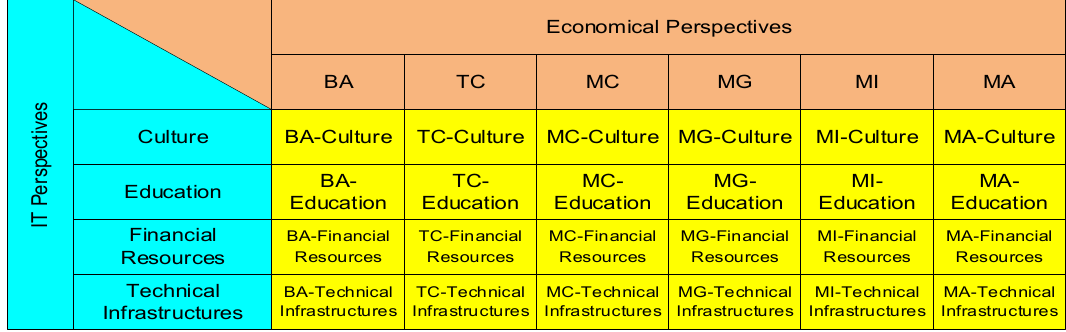
Fig. 1. A conceptual model for measuring the readiness of SMEs towards digitalization